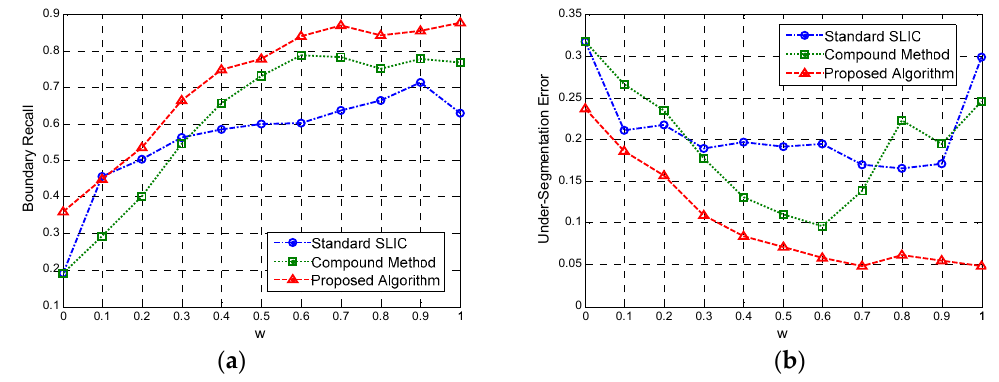
Figure 4. ( a ) boundary recall curves and ( b ) under-segmentation error plots obtained by three methods tested on the simulated SAR image.